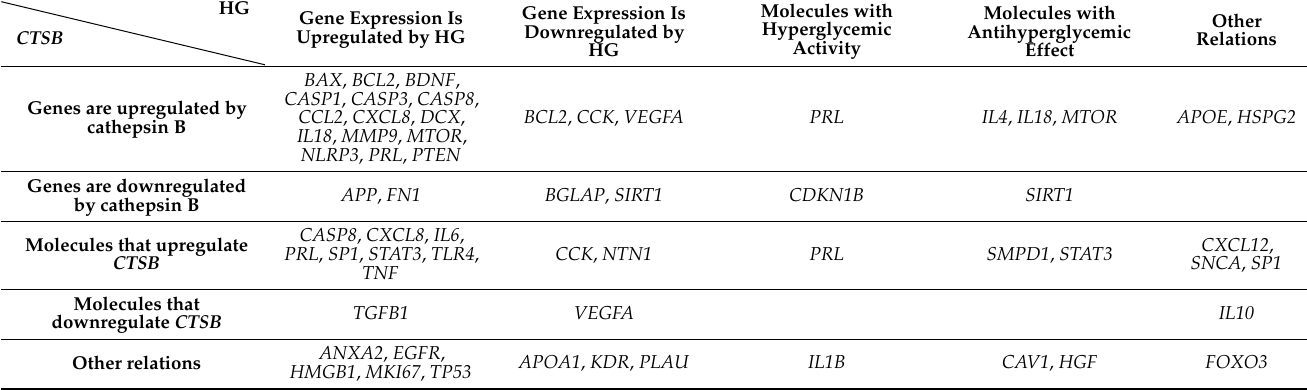
Table 6. Types of associations of the genes/proteins from hyperglycemia-related and cathepsin B (CTSB)-related networks with high glucose (HG) and cathepsin B ( STSB